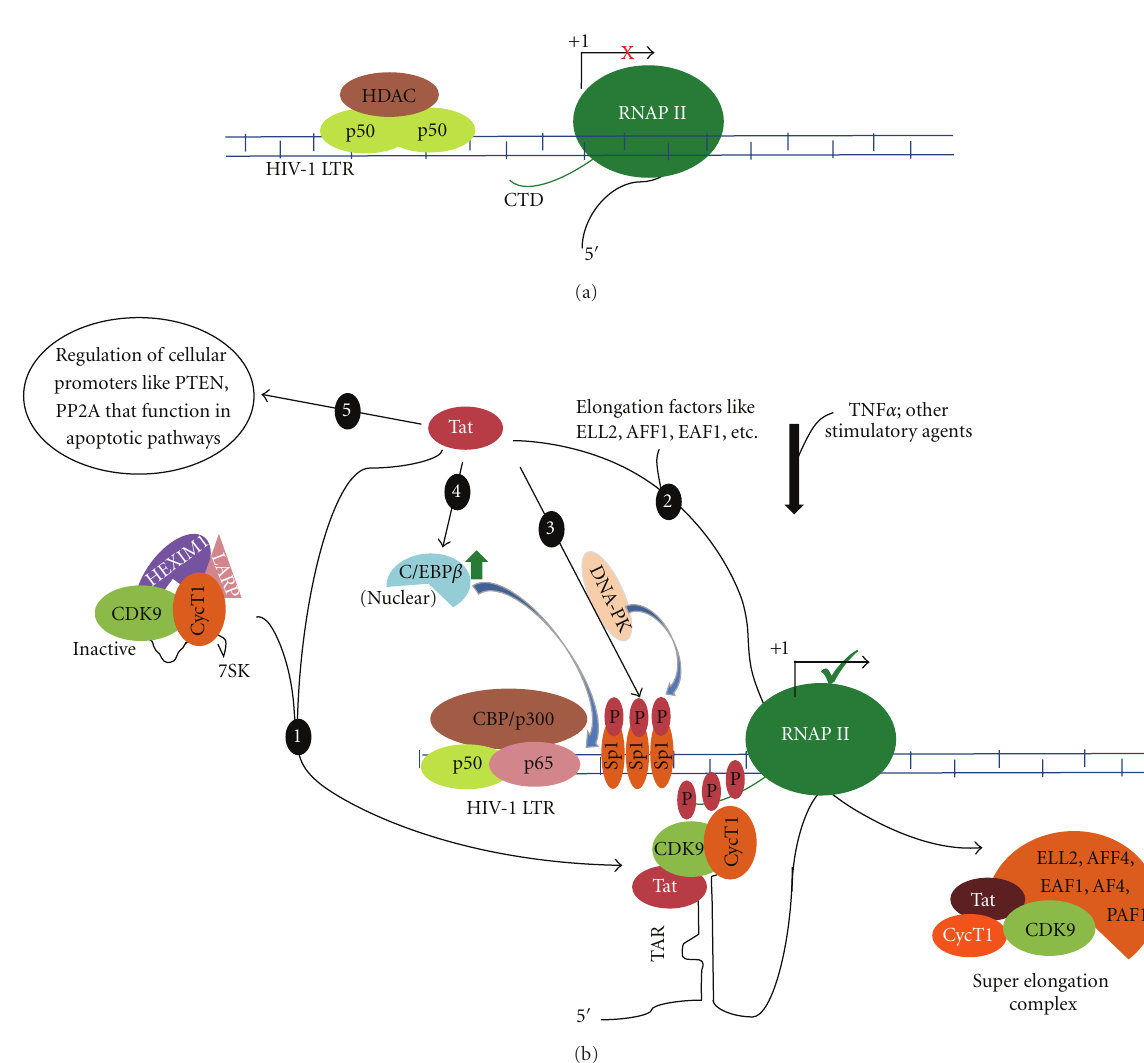
Figure 3: Functions of Tat. Tat plays a crucial role in synthesis of full-length HIV-1 mRNA transcripts. In the absence of Tat, the